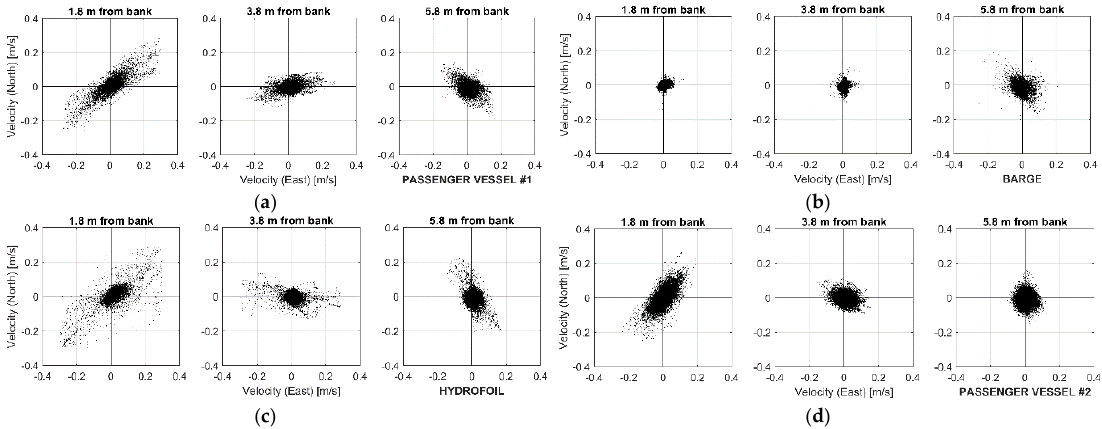
Figure 9. Horizontal direction distribution of measured near-bed velocity vectors at the three measurement points along the perpendicular profiler for: ( a ) passenger vessel #1; ( b ) the barge; ( c ) the hydrofoil; and ( d ) passenger vessel #2.